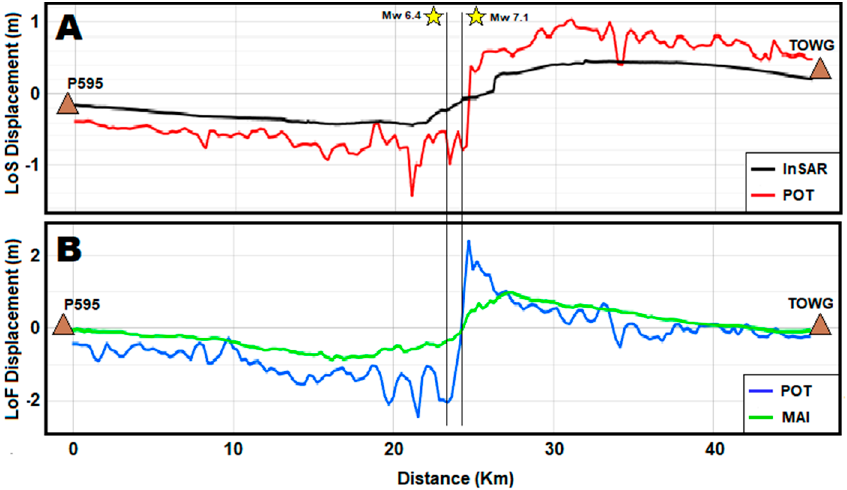
Figure 5. InSAR, MAI and POT data profiles along the transept connecting the P595 and TOWG GNSS stations; LOS InSAR and POT displacement ( A ) and LOF MAI and POT displacement ( B ).